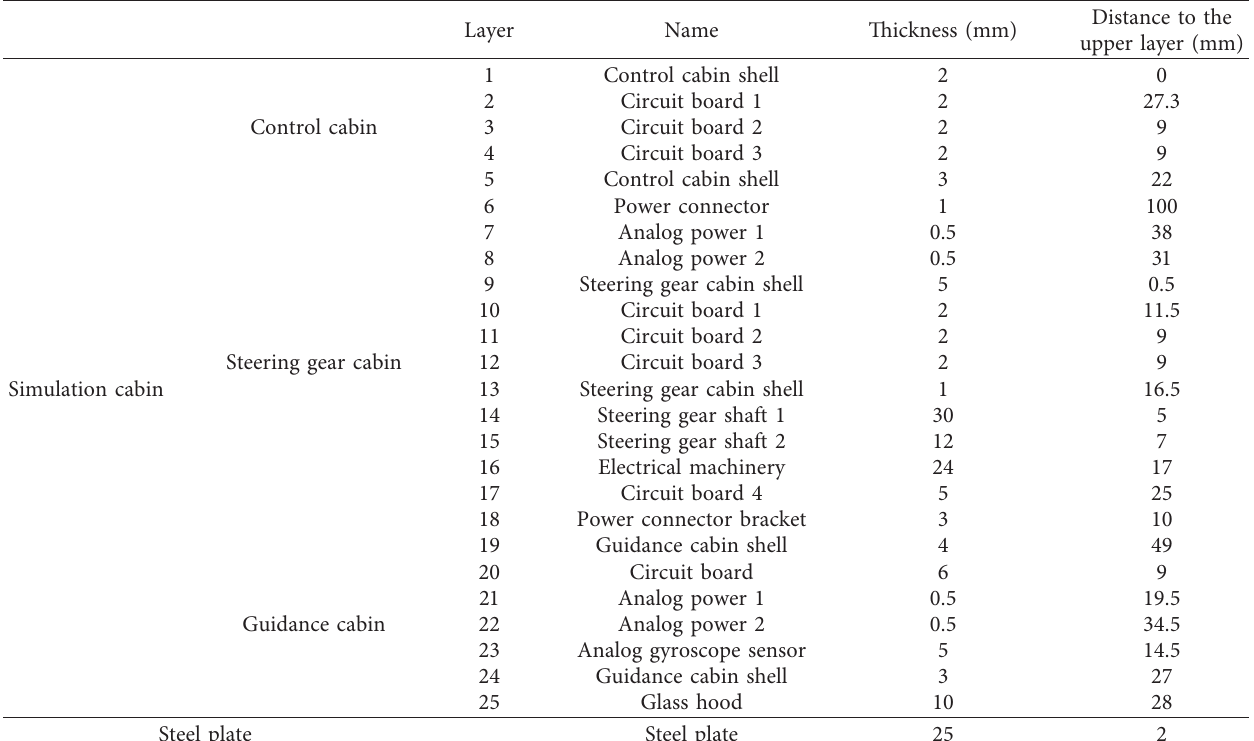
Table 1: Parameters of each layer slices.